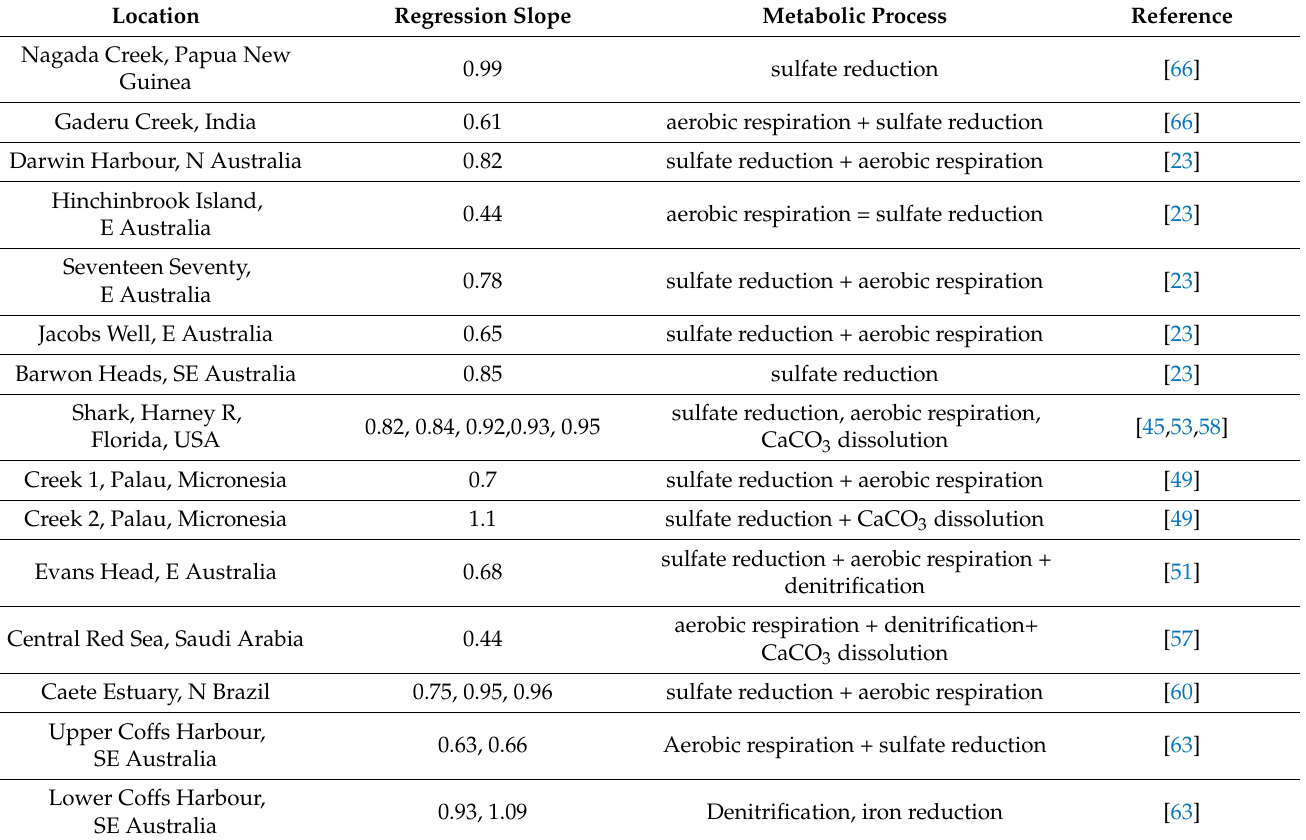
Table 3. Regression slopes and indicative metabolic processes affecting DIC–alkalinity relationships in mangrove